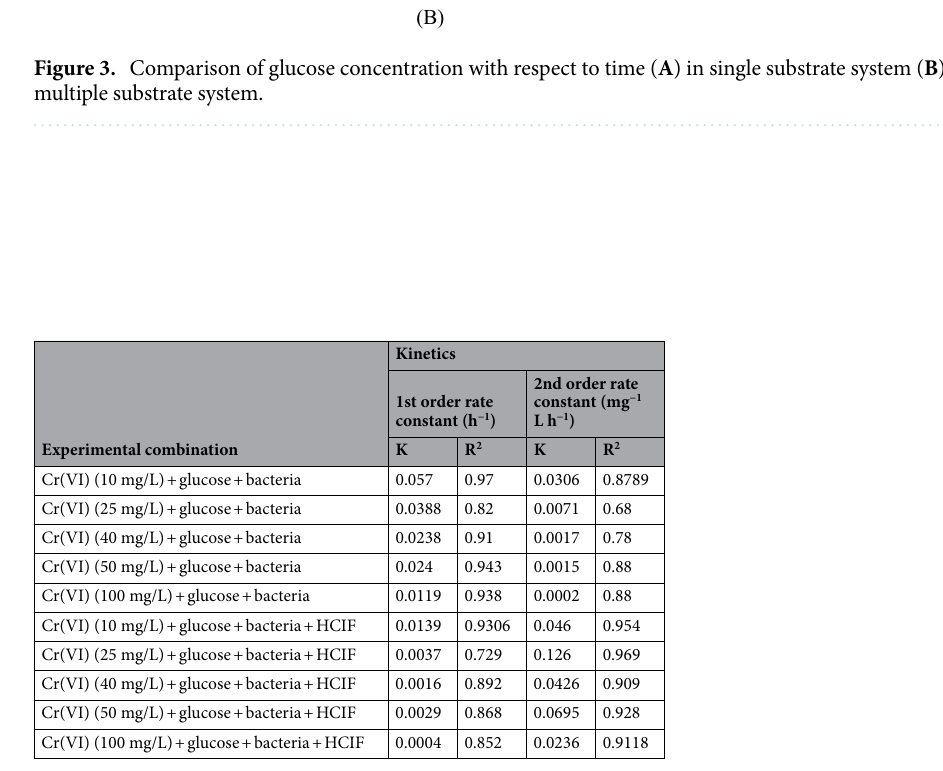
Table 1. Kinetic analysis for different substrate